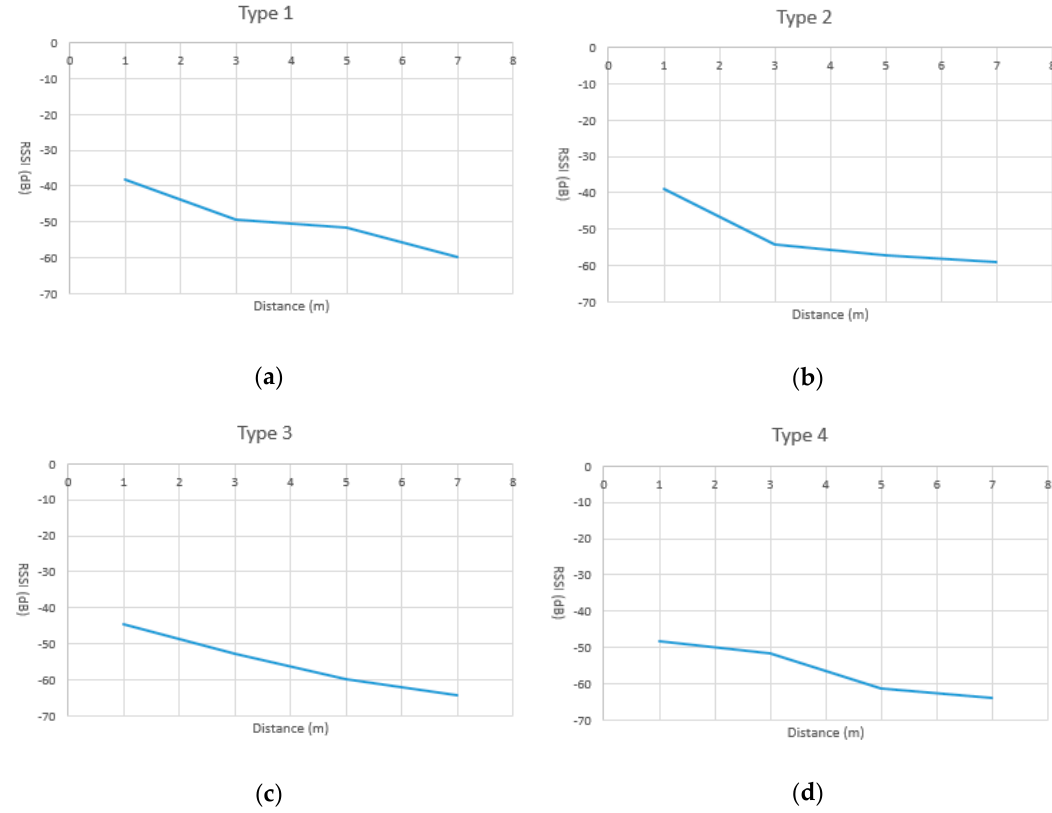
Figure 6. The regression model of the distance and the RSSI values. ( a ) The regression model of type 1 Lbeacon; ( b ) The regression model of type 2 Lbeacon; ( c ) The regression model of type 3 Lbeacon; ( d ) The regression model of type 4 Lbeacon;.